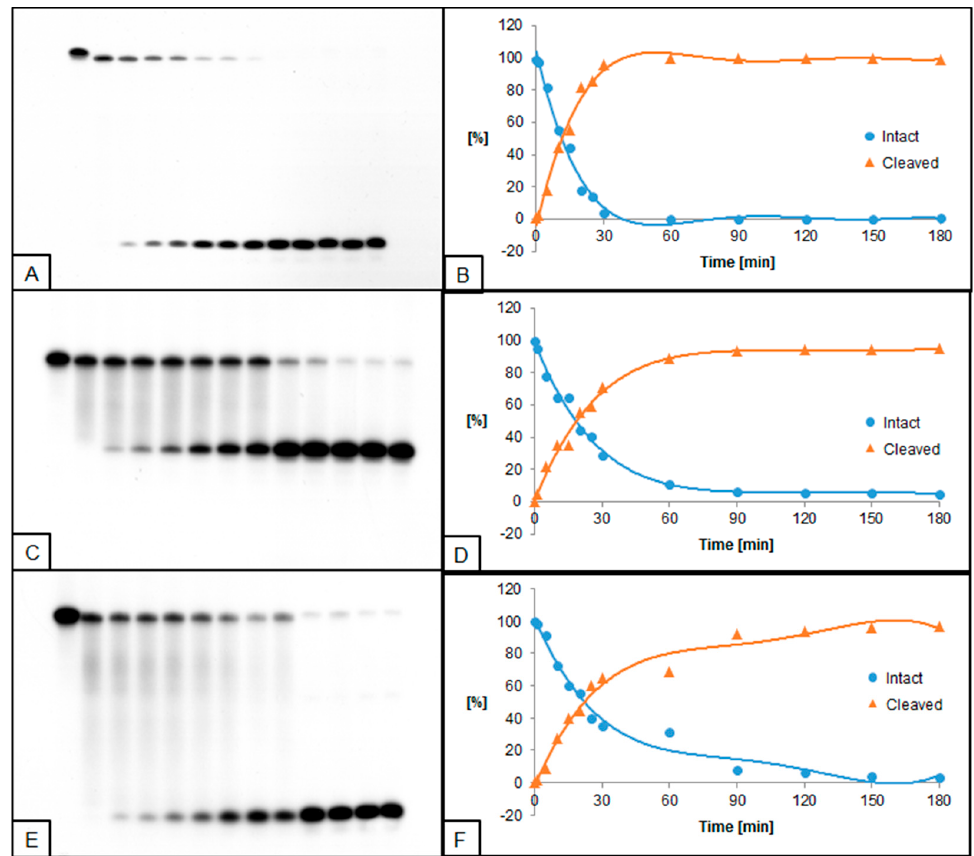
Figure 4. Cleavage of dsDNA containing dU and (5 ′ R ) − 5 ′ ,8-cyclo-2 ′ -deoxyadenosine (RcdA) by 0.5 U UDG and 0.02 U hAPE1. ( A , B ) dU( − 5)RcdA; ( C , D ) dU(+5)RcdA; ( E , F ) dU( − 5)(+5)RcdA. ( A , C , E ) show 13 lanes each, which correspond to reaction times 0, 1, 5, 10, 15, 20, 25, 30, 60, 90, 120, 150, and 180 min starting from the left. ( B , D , F ) show the quantity losses of intact ssDNA (blue) and the quantity increases of SSB-DNA (orange).